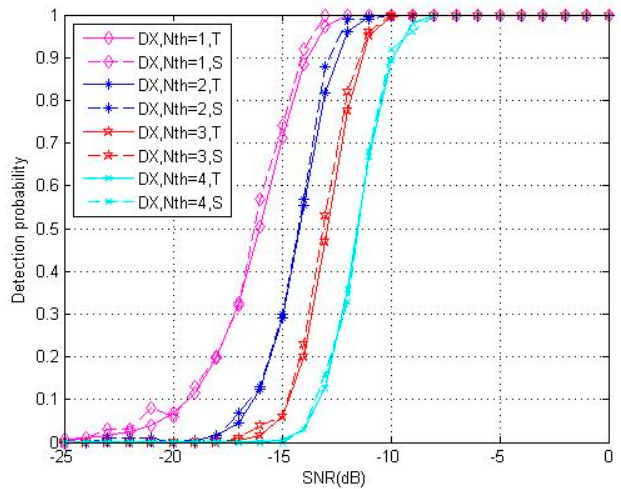
Figure 4. Theoretical (“T”, continuous line) and simulation (“S”, dotted line) results for detection probability under 1–4 verification times ( N th ) of DC-XFAST (“DX”) with folding number equals to 10.